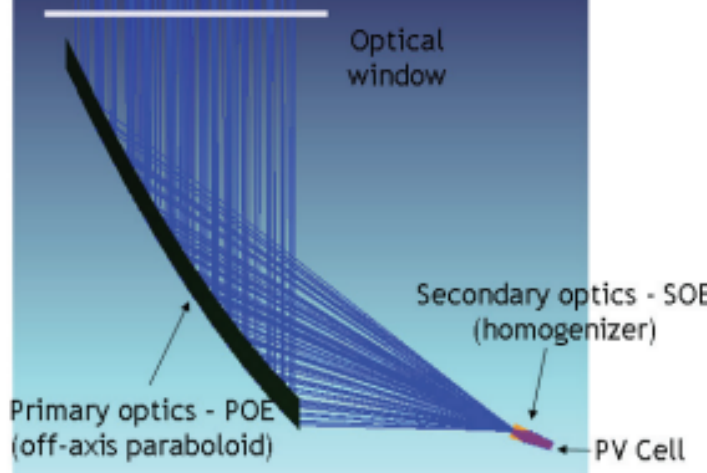
Figure 41. Optical design of a mirror dish as POE associated with a pyramid proposed by Trespidi et al. [74]. Reprinted from F. Trespidi and Gianluca Timò, Optical Design of an Off-axis Mirror Based Solar Concentrator, AIP Conference Proceedings 18812017, 030008, with permission from Elsevier.